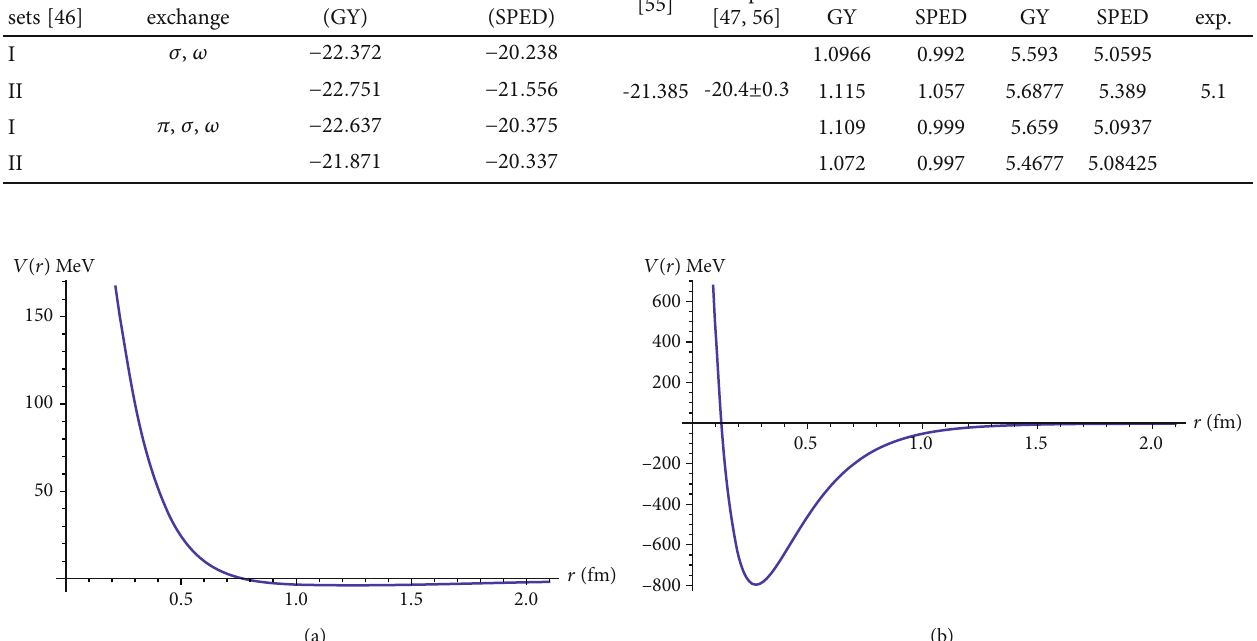
Figure 1: The potential with GY and SPED functions, respectively, of 2 H nuclei as OBEP through the exchange of σ and ω mesons, with parameter I.